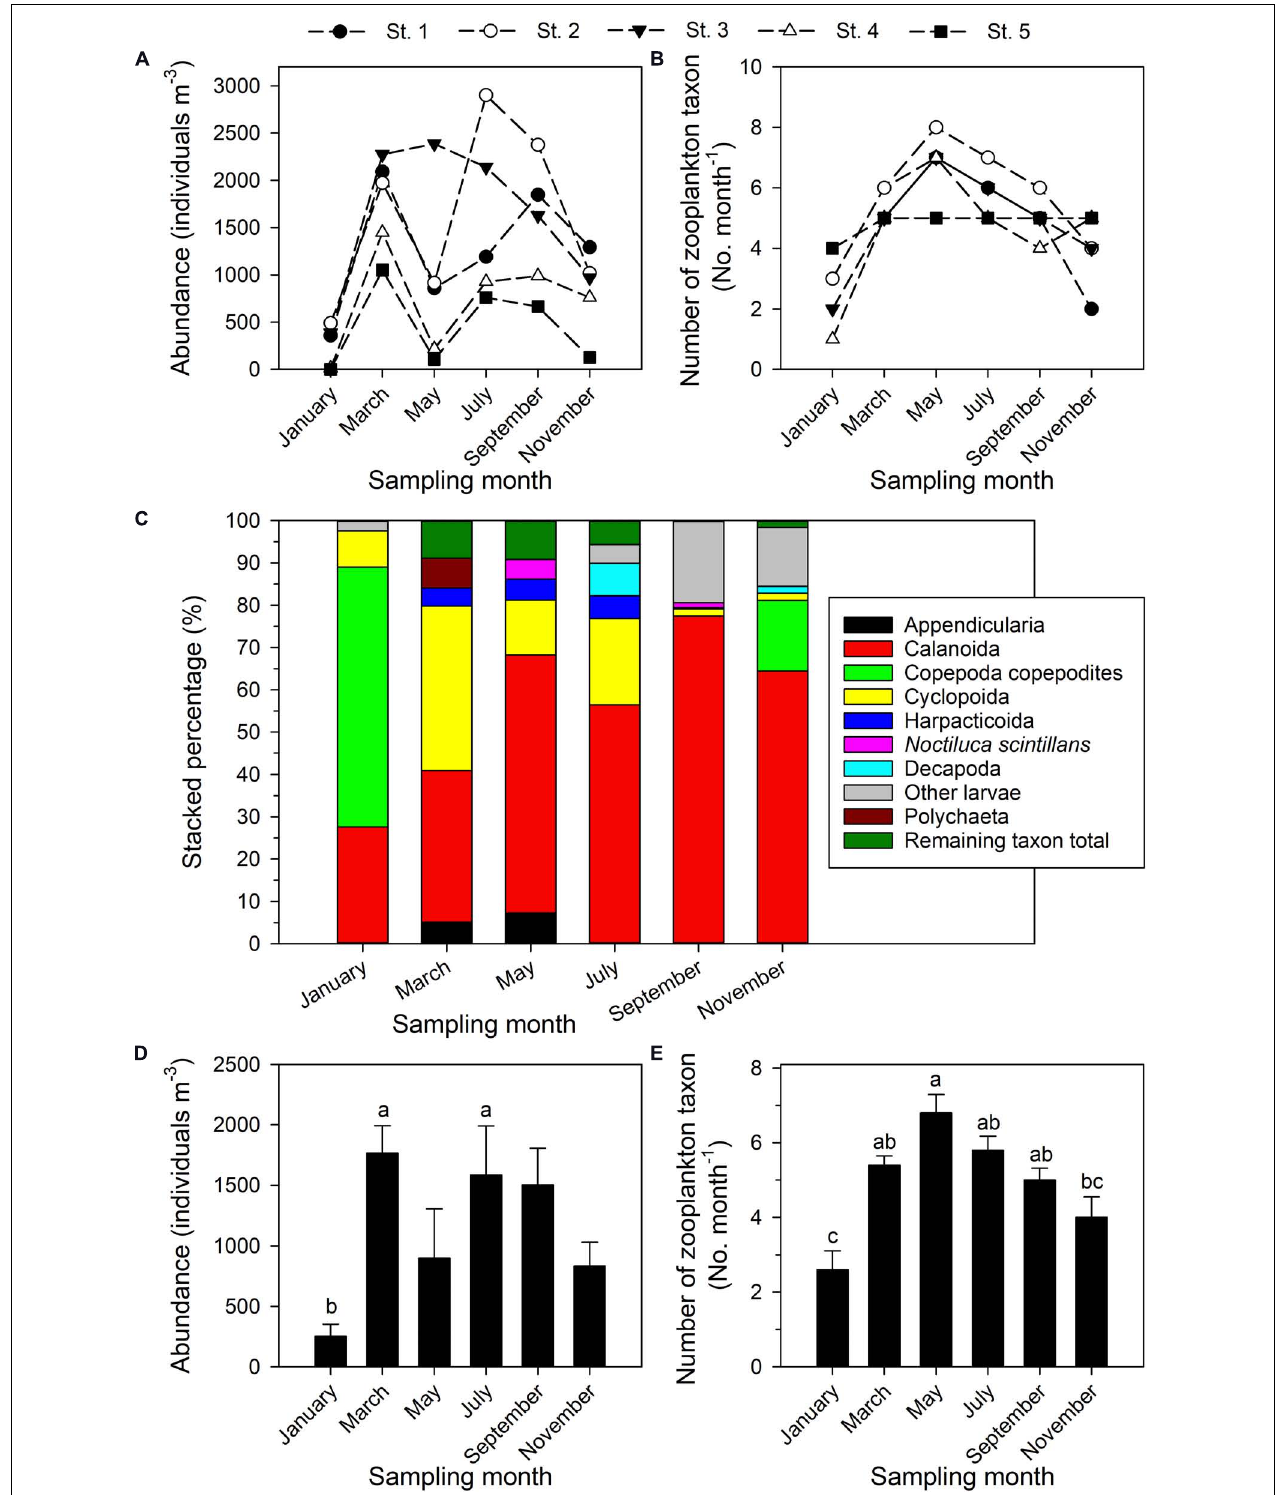
FIGURE 4 | Total zooplankton abundance (A) , number of higher taxa or other categories of zooplankton (B) , relative abundances of five most dominant zooplankton taxa (C) ; values (mean ± standard deviation) on each bimonthly sampling date in 2014 of abundance (D) and number of higher taxa or other categories of zooplankton (E) . Superscripts (a–c) denote significant differences ( p < 0.05, one-way ANOVA). The remaining taxon total is the sum of the percentages of all taxa aside from the top 5.